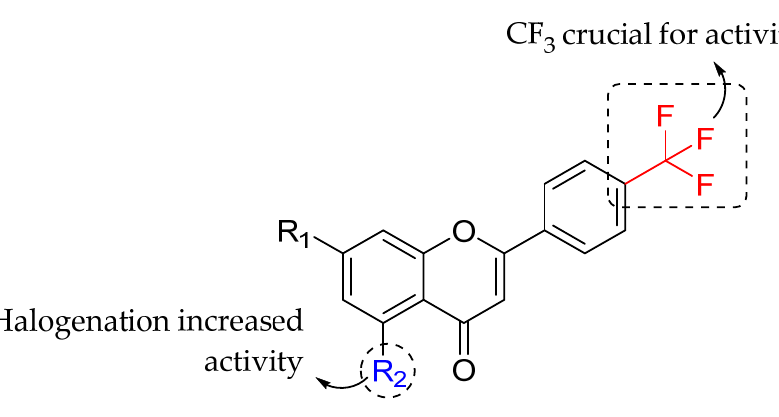
Figure 32. The structural-activity analysis of tested flavone derivatives containing halogens